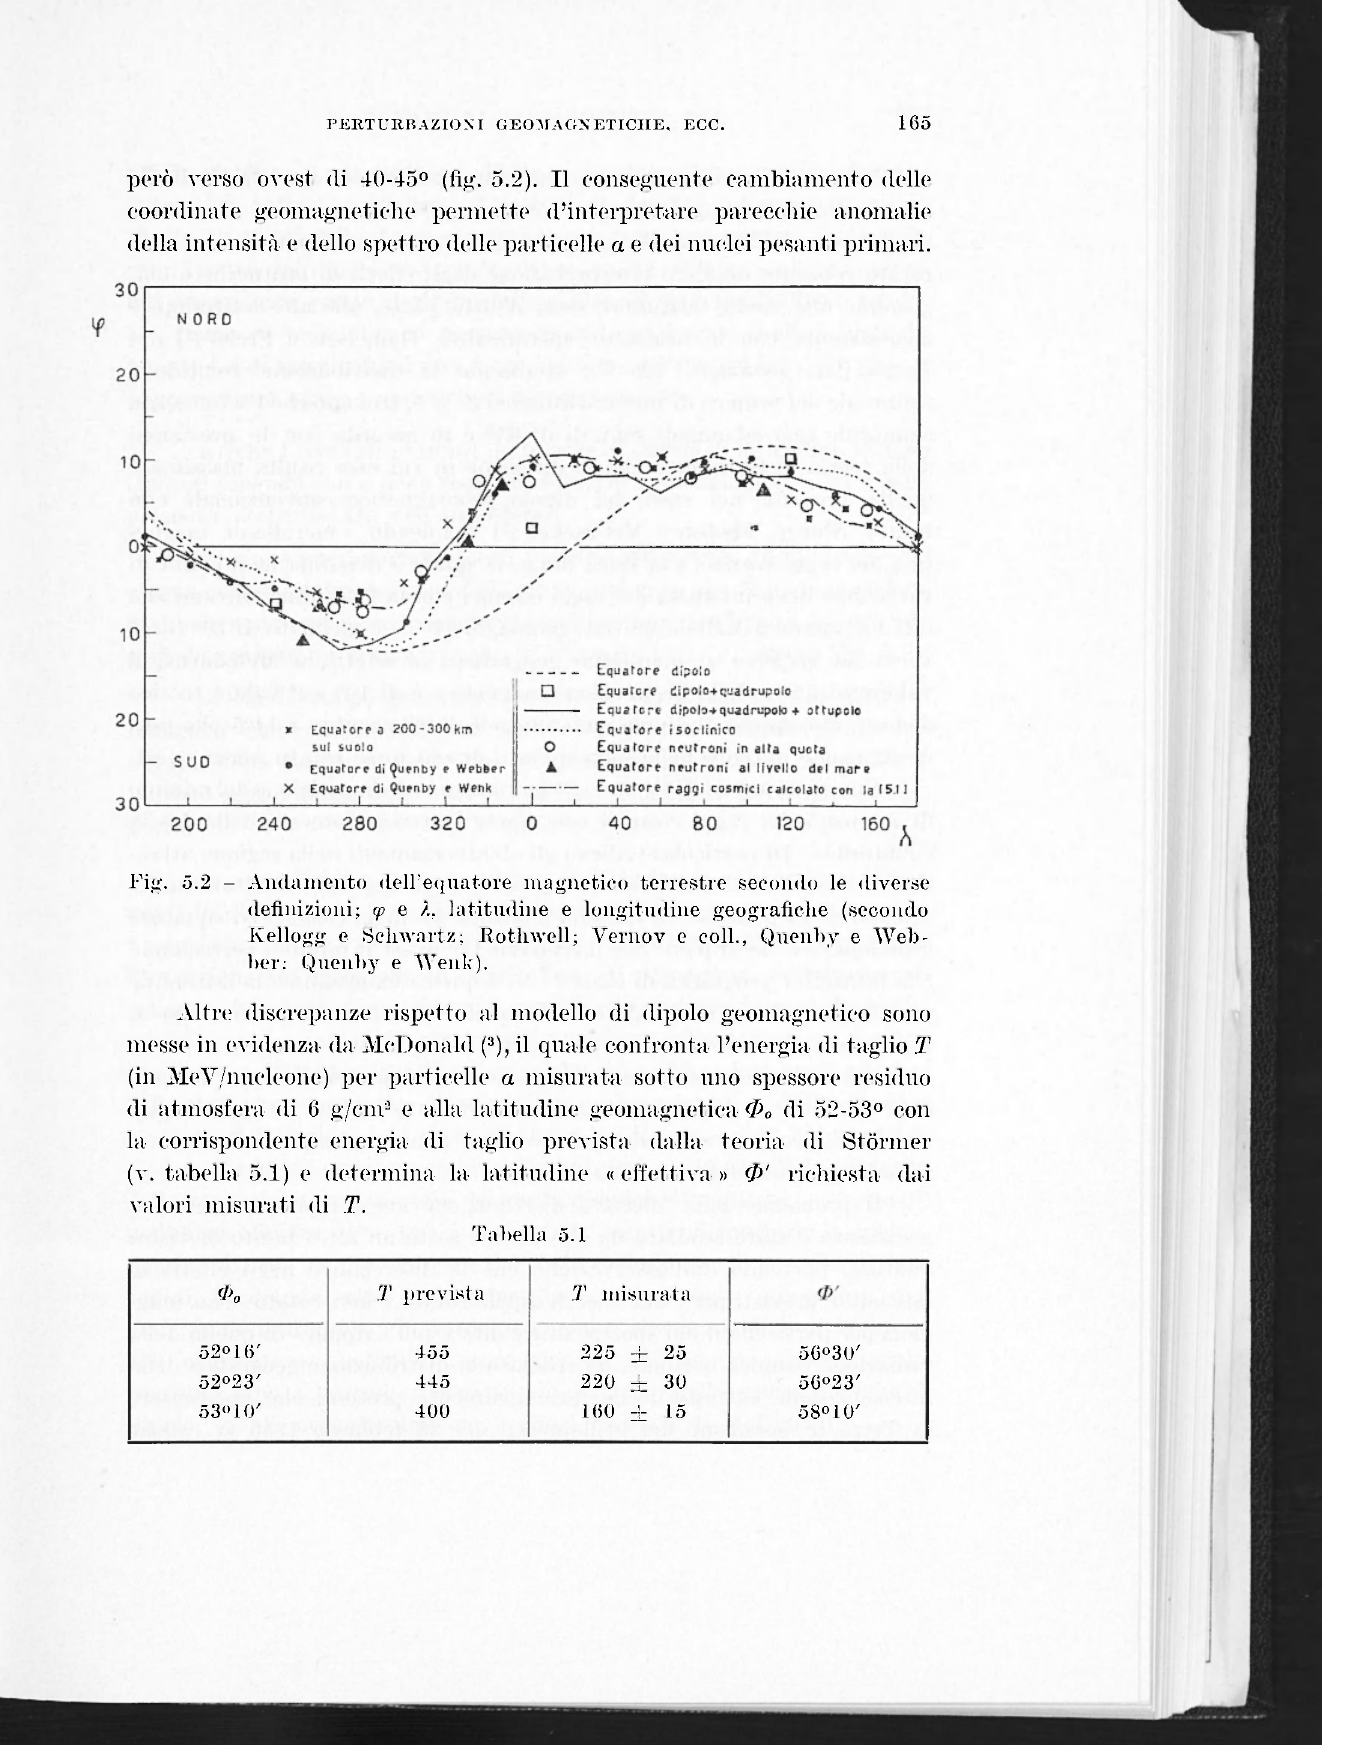
(v. tabella 5.1) e determina la latitudine «effettiva» 0' richiesta dai valori misurati di